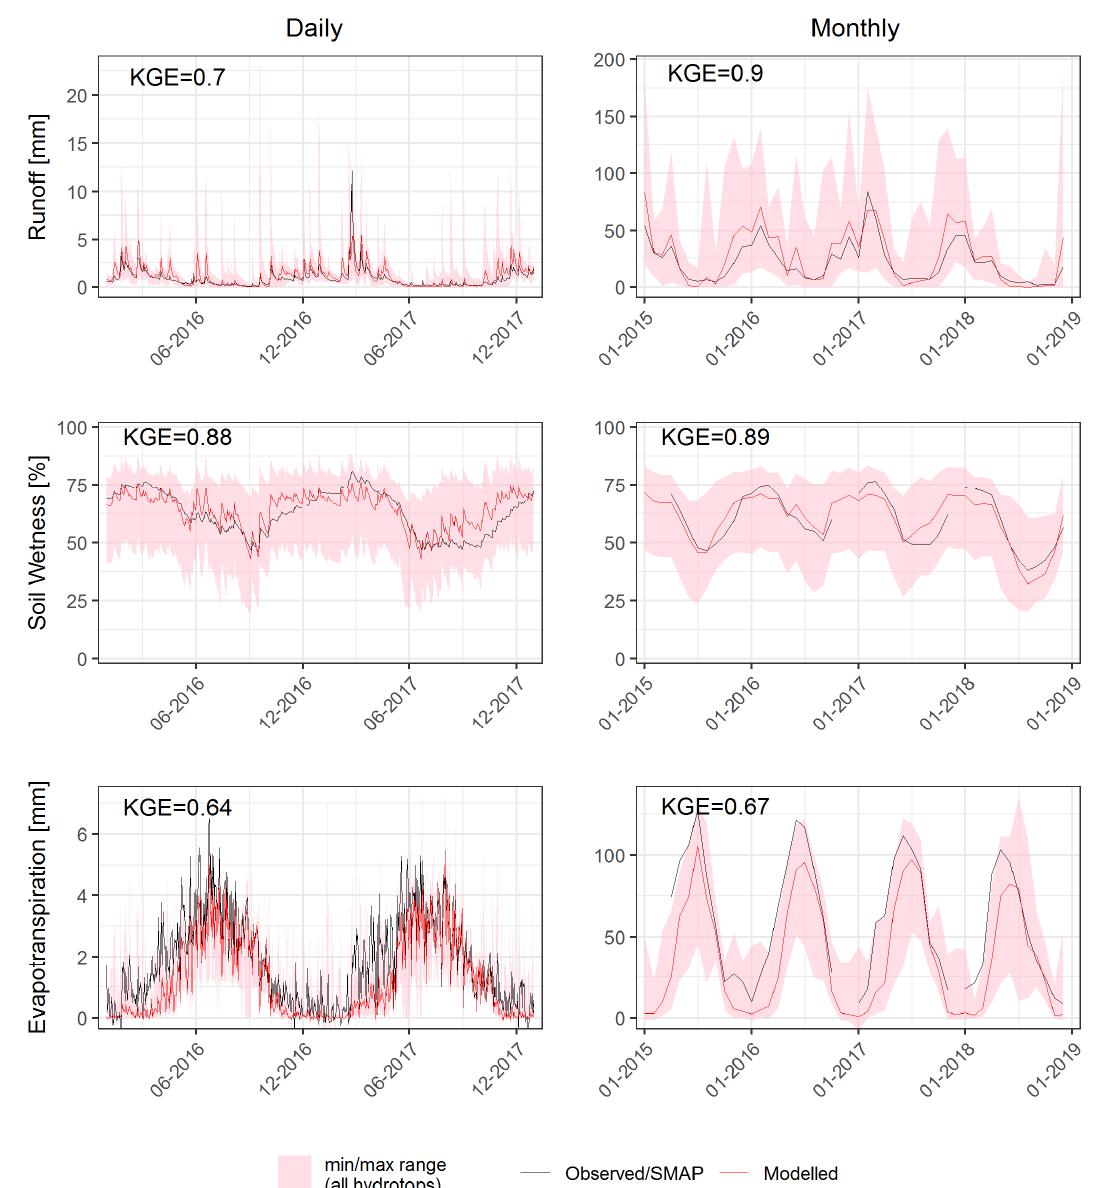
Figure 5. Daily and monthly time series of simulated (weighted mean and maximum/minimum range from all hydrotops) runoff, soil wetness, and evapotranspiration (ET) compared with observations for the Krummenhennersdorf catchment (4) as exemplary. The data gaps of monthly soil moisture (SM) and ET (observed/ soil moisture active passive data (SMAP)) are caused by missing values in SMAP_L4_GPH product, thus, are not considered in the validation.